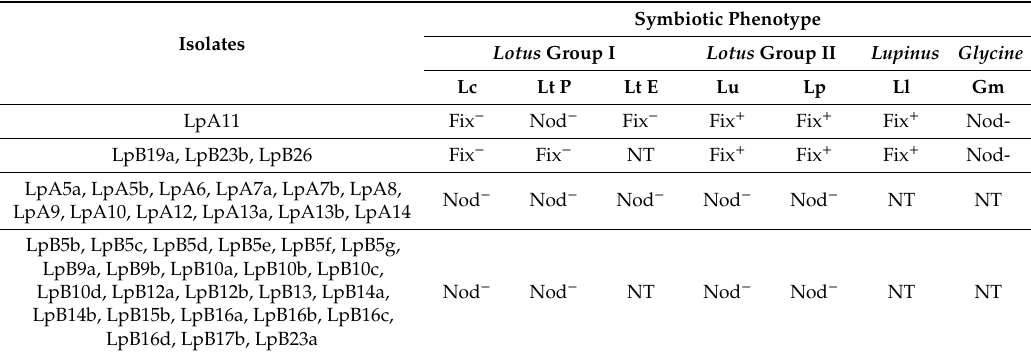
Table 3. Host range assays performed in di ff erent legume host plants inoculated with the di ff erent bacterial isolates.